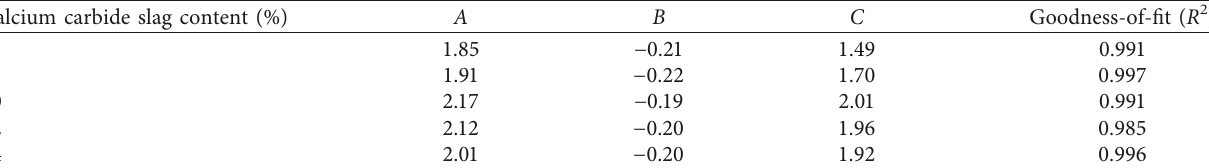
Table 4: Parameters of the exponential relationship.